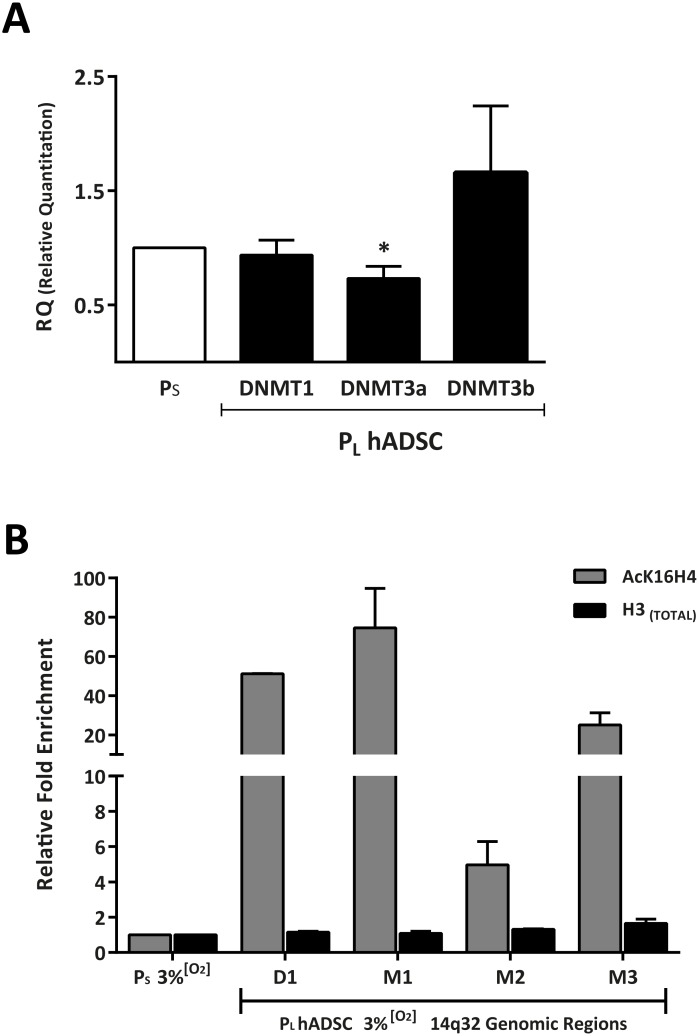
Epigenetic analysis of DLK1-DIO3 DMR regions.(A) Relative quantitation of DNMT1, DNMT3a and DNMT3b (hADSCs; n = 5 biological replicates). Data represent mean ± SEM (* p <0.05; two-tailed paired t-test). (B) Fold enrichment of AcK16H4 relative to total H3 in hADSC05 cultured at 3% [O2], comparing PS and PL samples. Enriched DNA was analyzed by qPCR using primers specific for the different regions (D1, M1–M3; see S1 Fig and S4 Table). Nonspecific adjustment (dCq) was calculated by (dCq = Cq[IP] − Cq[IgG]). Fold enrichment was calculated as 2^(-ddCq) where ddCq is (ddCq = Cq[PL] − Cq[PS]).